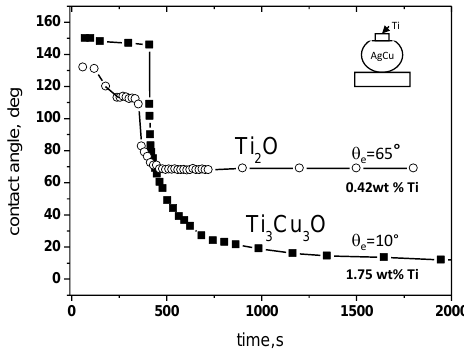
Figure 18. Contact angle as a function of time for two CuAg-Ti droplets of different composition processed in situ on monocrystalline alumina in He at 900 °C. According to